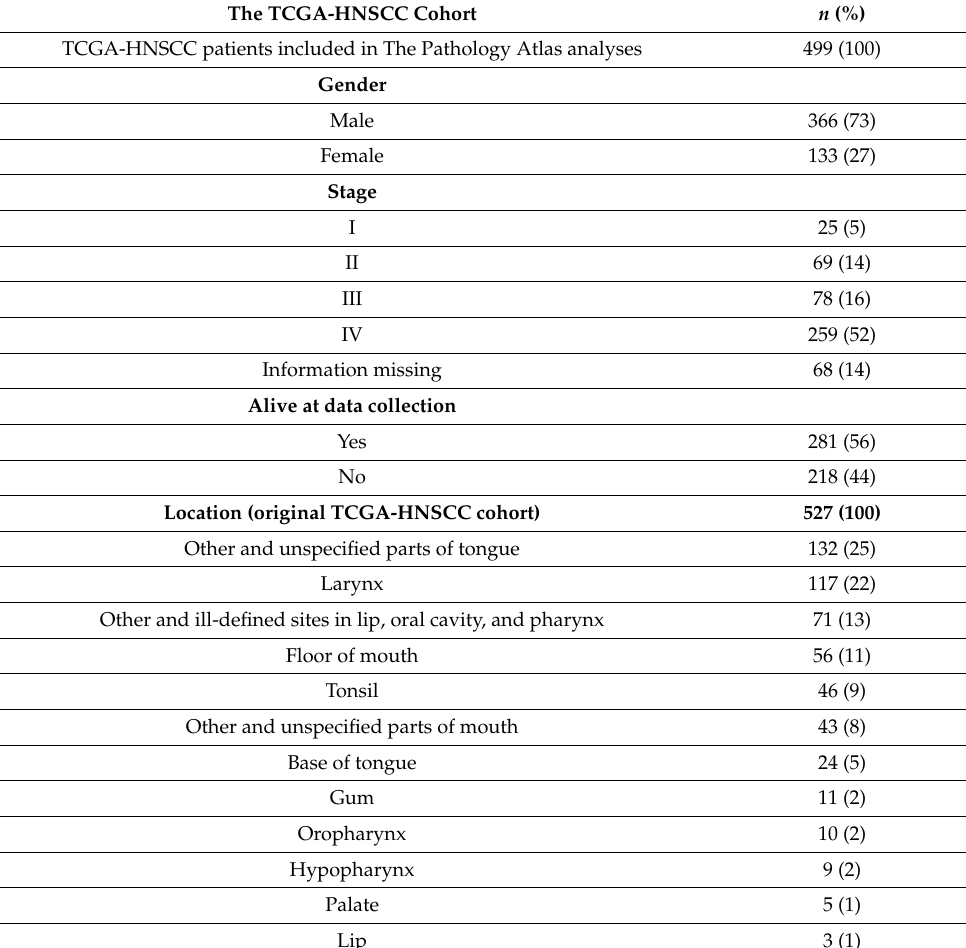
Table 1. Clinical characteristics of the TCGA-HNSCC